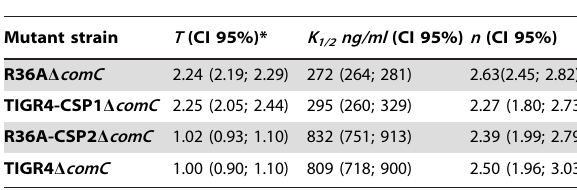
Table 1. Hill function parameters estimated by non-linear regression for the transformation efficiency assay of D comC